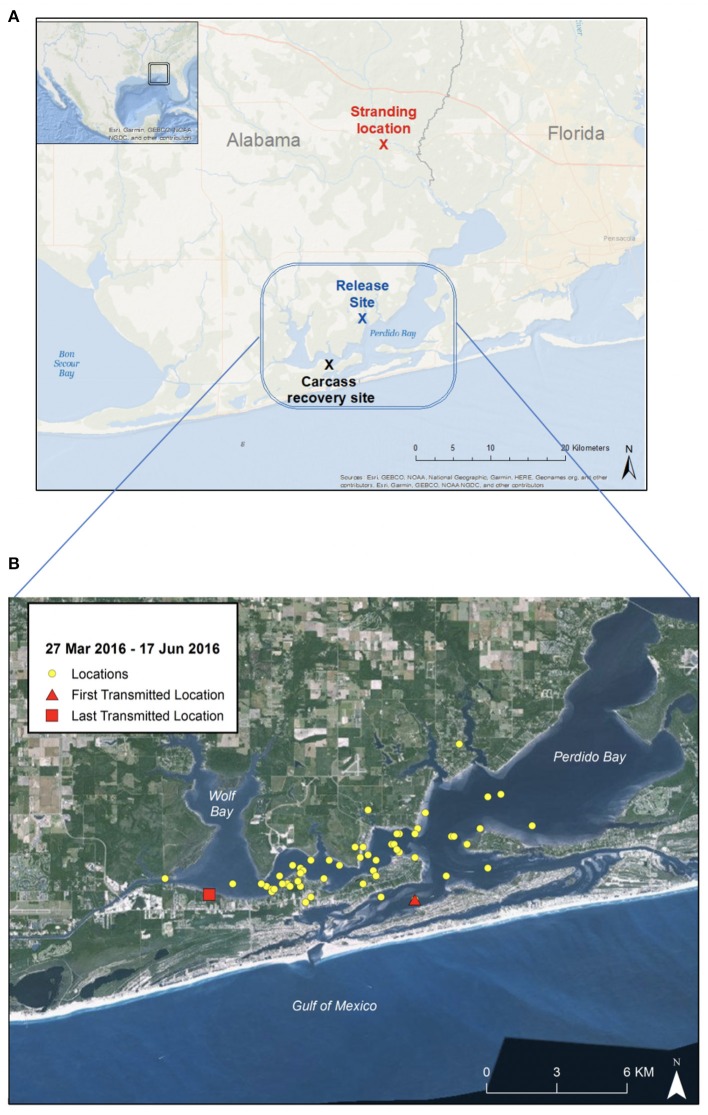
Maps of Perdido Bay, Alabama. (A) Rescue location (red), release site (blue), and site of carcass recovery (black) with blue rectangle region indicating area dolphin spent time during 12-week recovery period. (B) Close-up map of Perdido Bay showing satellite tracking signal locations (27 March 2016 to 17 June 2016). The dolphin remained within Perdido Bay, a known estuarine habitat for bottlenose dolphins, and did not appear to travel south into the Gulf of Mexico during the post-release period.